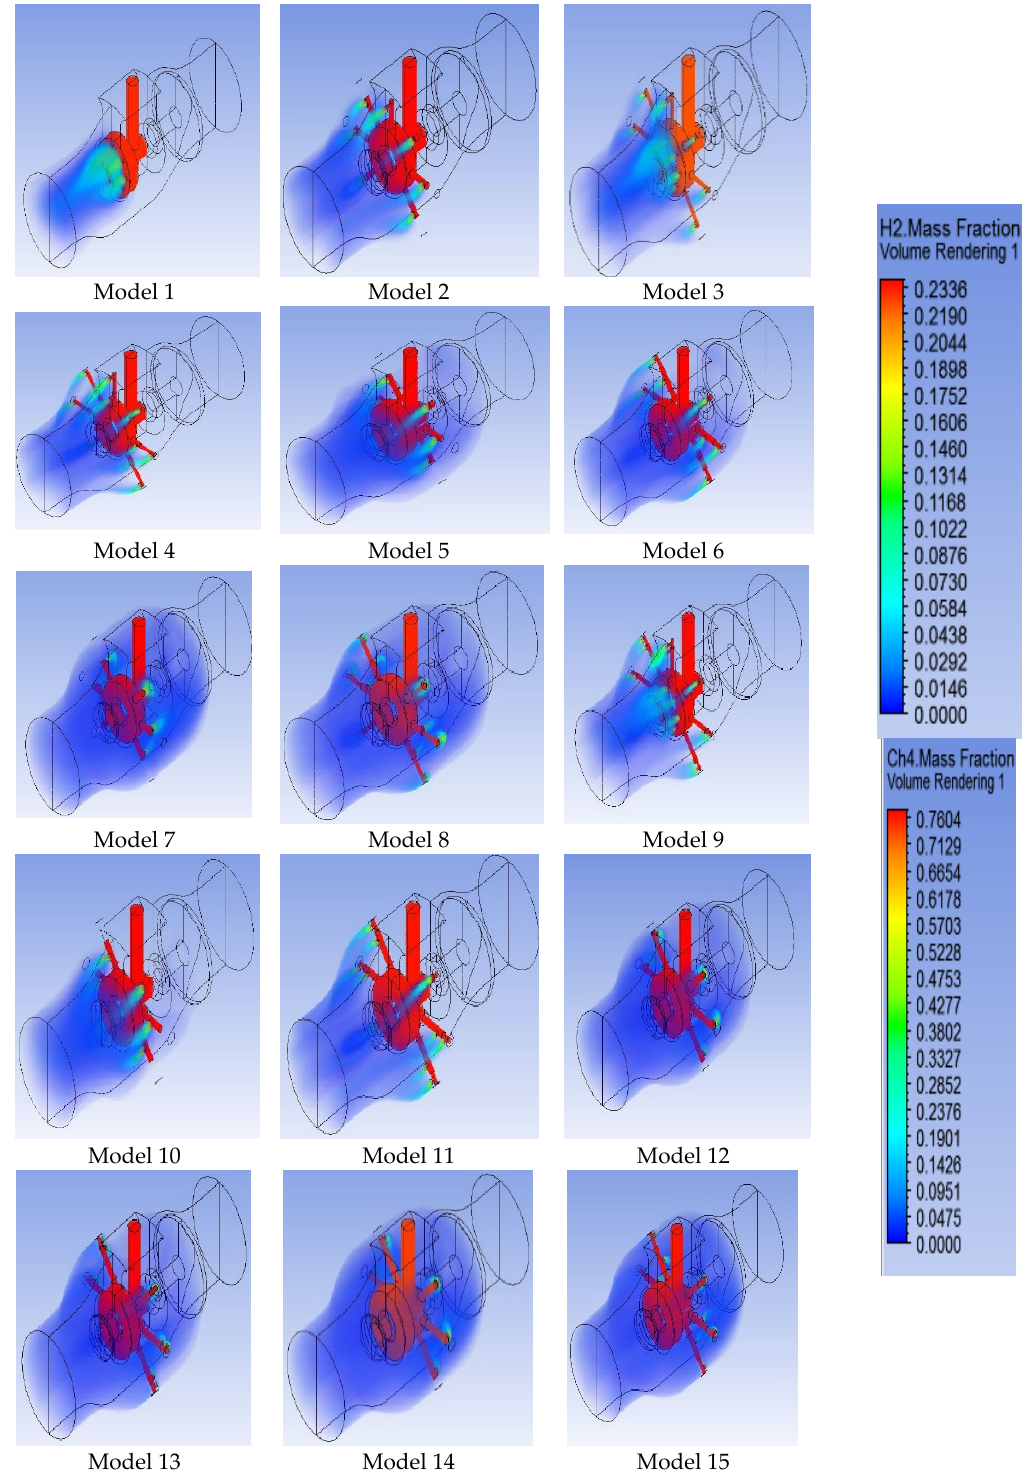
Figure 13. Volume rendering for methane mass fraction of the existing mixer and new mixer models (best case for each model) under Air-HCNG ratio 51.315.